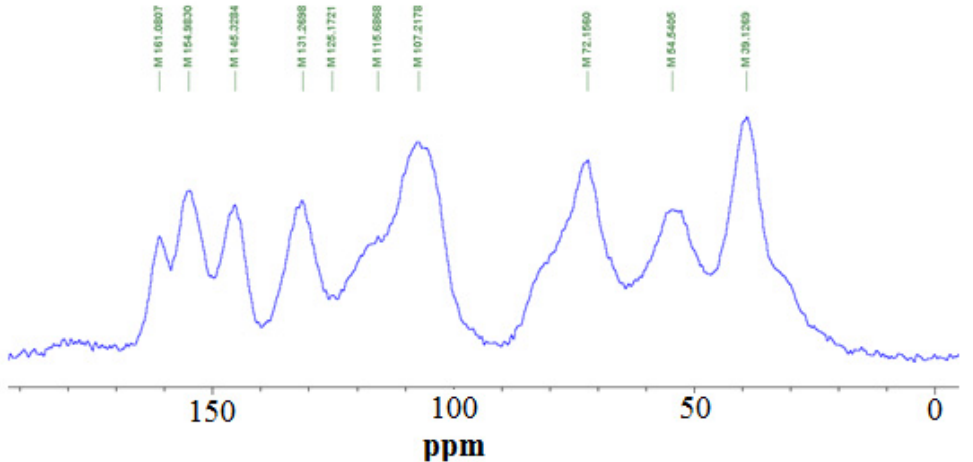
Figure 14. Cross-polarisation/magic-angle spinning (CP-MAS) 13 C NMR spectrum of the reaction product of mimosa flavonoid tannin with the hyperbranched tris(2-amino ethyl)amine-urea polymer at 100 ◦